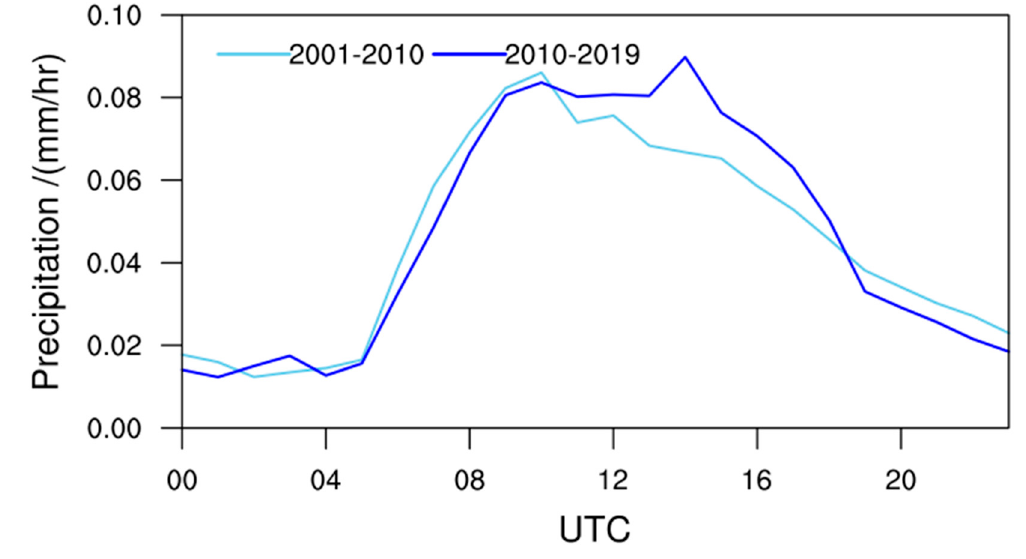
Table 2. Spatial correlation coefficients between nighttime precipitation differences and precipita- tion differences among the two decades in different time periods.